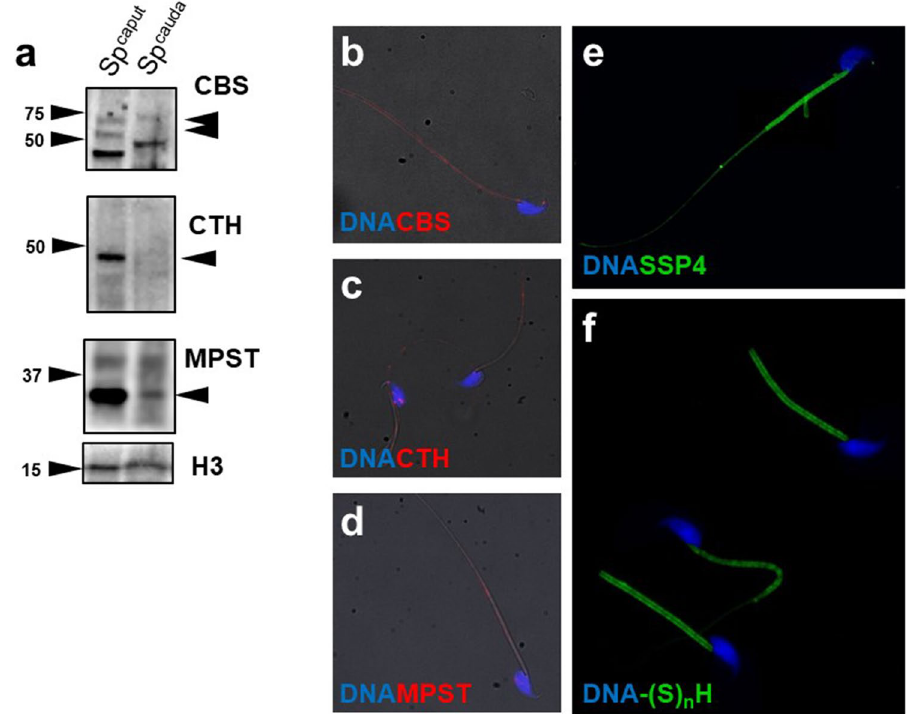
Figure 4. Production of H 2 S, its enzymes and persulfidation (–(S) n H) in mouse spermatozoa. ( a ) Western blot detection of cystathionine β-synthase (CBS), cystathionine γ-lyase (CTH) and 3-mercaptopyruvate sulfurtransferase (MPST) in mouse spermatozoa during their maturation in the epididymis. ( b – d ) Immunocytochemistry of CBS, CTH and MPST. ( e ) Localization of H 2 S production by Sulfane Sulfur Probe 4 (SSP4) and ( f ) –(S) n H. Spermatozoa were magnified